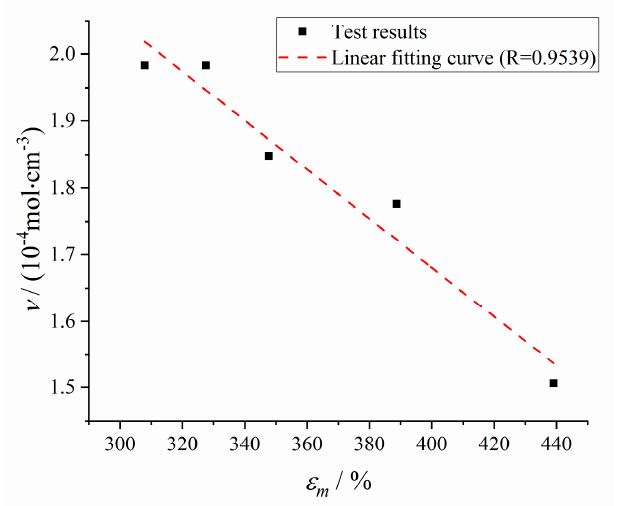
Figure 4. Correlation curve between maximum elongation and crosslinking density.